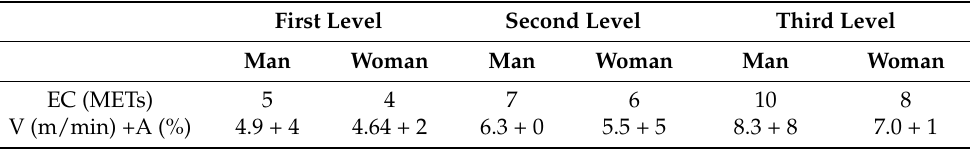
Table 1. Correspondence between exercise intensity and speed gradient in the three-level load